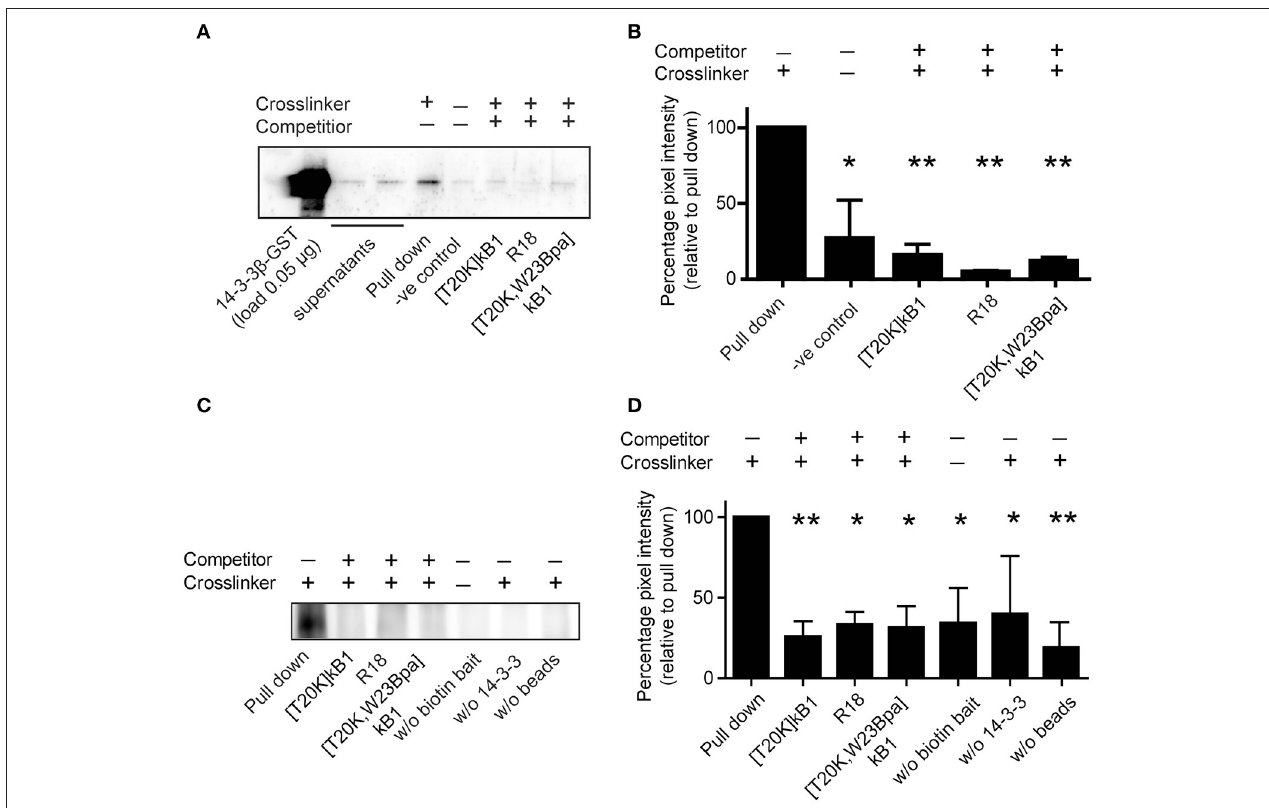
FIGURE 5 | Co-precipitation of purified GST-tagged isoform 14-3-3 β with cyclotide probe [T20K,W23Bpa]kB1. (A) Protein/peptide interaction was confirmed by co-precipitation of representative recombinant GST-tagged 14-3-3 β isoform with biotinylated crosslinker probe [T20K,W23Bpa]kB1. Validation of the interaction was obtained by competition experiments using non-biotinylated competitors [T20K]kB1, R18, and [T20K,W23Bpa]kB1, respectively. Beads and crosslinker probe [T20K,W23Bpa]kB1 only, were used as a control. After precipitation of biotinylated analytes with streptavidin beads, 14-3-3 positive samples were identified using an anti-GST primary antibody. A representative immunoblot is shown. (B) Pixel quantification of two independent immunoblots revealed significant reduction of the GST-tagged 14-3-3 β isoform in the presence of non-biotinylated competitors. (C) In vitro co-precipitation was performed using the biotin tag for the precipitation to test for any binding of the probe to the GST tag of the 14-3-3 β protein. As control the following conditions were used: (i) samples without biotinylated crosslinker, (ii) samples without 14-3-3 β GST protein and (iii) samples without streptavidin beads. A representative immunoblot of three independent experiments is shown. (D) Pixel quantification of protein bands of the 55 kDa band (14-3-3 β conjugated to a GST-tag and crosslinked to the biotinylated cyclotide probe [T20K,W23Bpa]kB1). Significance was analyzed by one-way ANOVA analysis with Bonferroni Post-Hoc test; * P < 0.05, ** P <